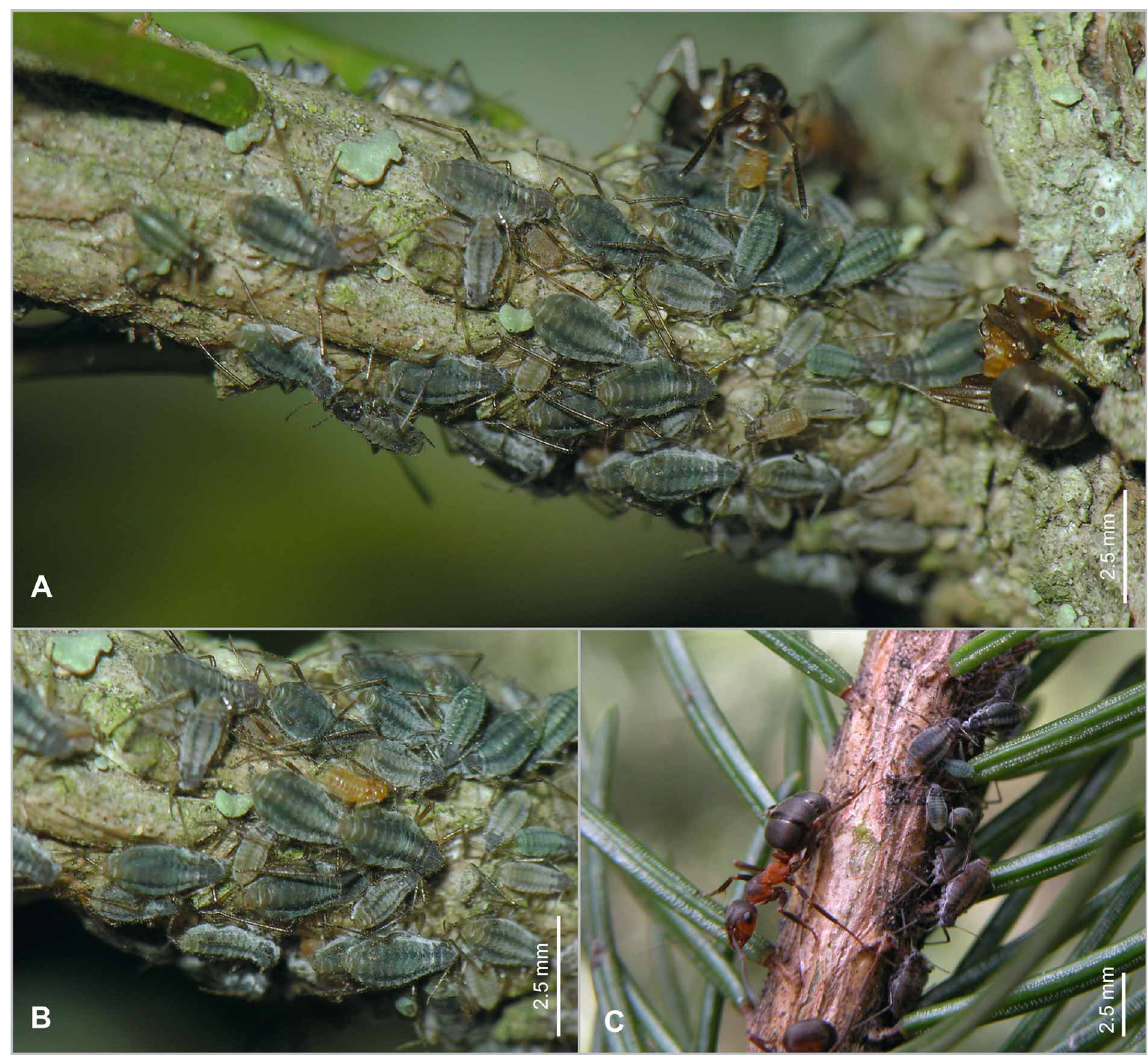
Fig. 38. Cinara (Cinara) piceicola (Cholodkovsky, 1896). Apterae and juveniles on branches of Picea abies , attended by Formica aquilonia Yarrow,